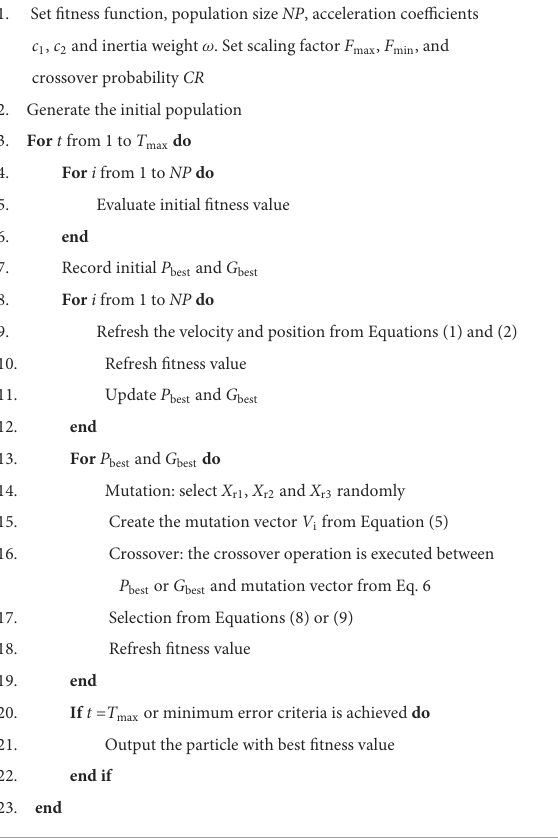
TABLE 3 Algorithm III: DePSO. Improved particle swarm optimization